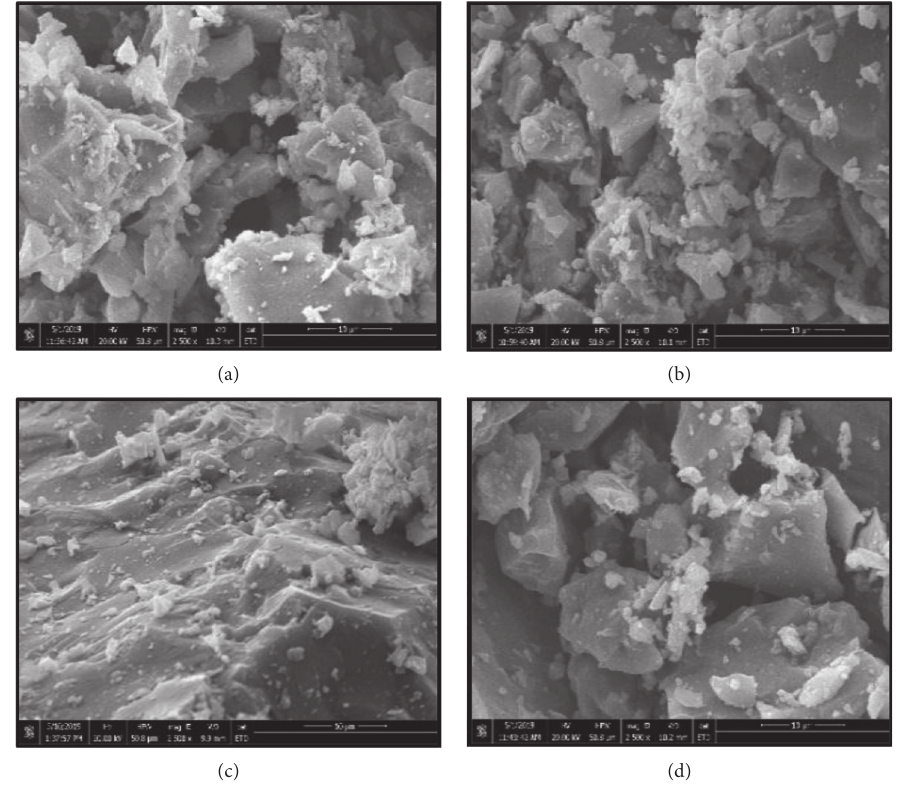
Figure 12: The SEM of floc structure in the four phases (shear rate � 400s − 1 and shear time � 120s): (a) primary flocculation, (b) primary broken, (c) secondary flocculation, and (d) secondary broken.